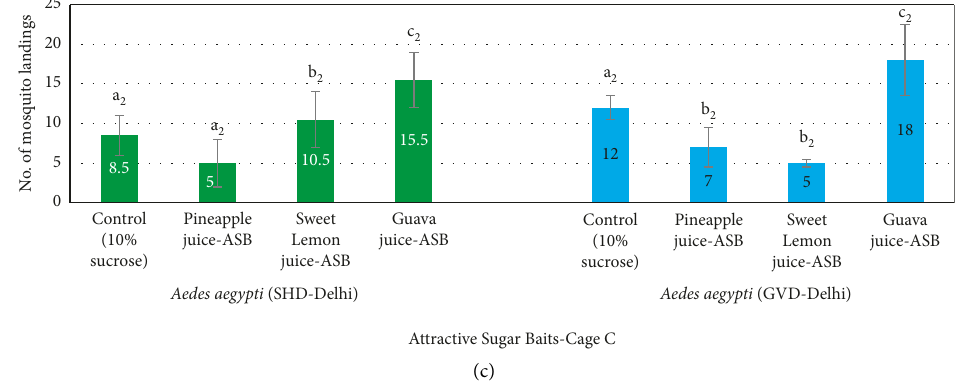
Figure 3: Screening assay showing number of landings by the field population of Aedes aegypti (SHD-Delhi) and Aedes aegypti (GVD- Delhi) on different ASBs placed along with a control in one cage.